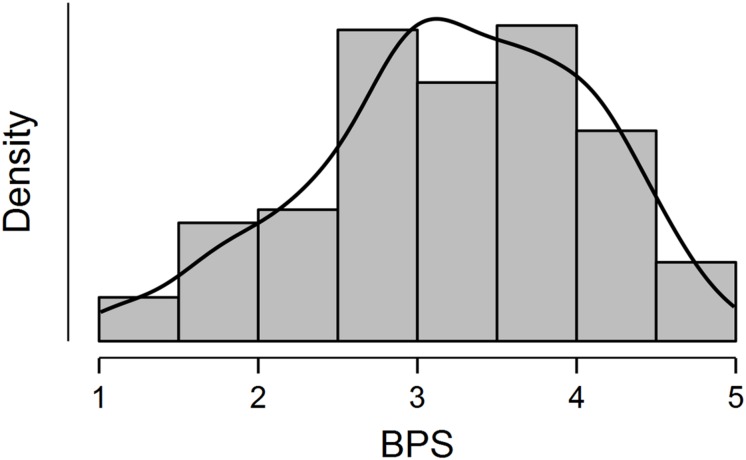
Histogram and smoothed density plot showing distribution of total raw scores of the Polish version of the Bedtime Procrastination Scale (BPS) in Sample 2.